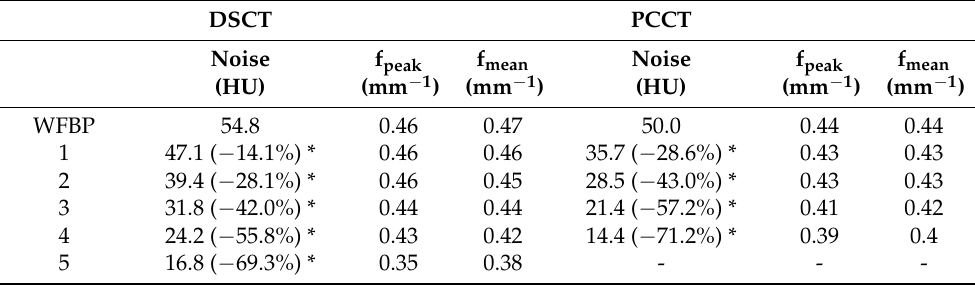
Table 4. Global noise and its noise reduction in percentages relative to WFBP, peak frequency (f peak ) and averaged frequency (f mean ) values for all reconstruction levels for both CTs for a 10 mGy acqui- sition.